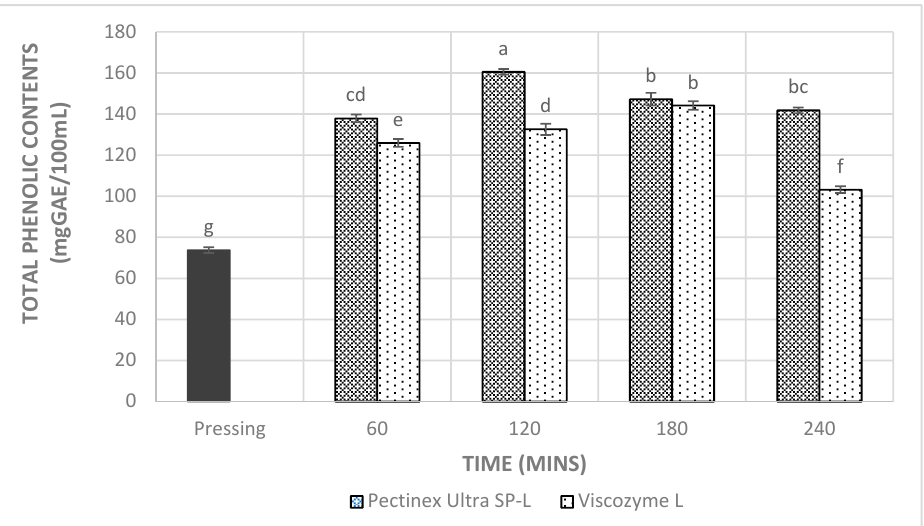
Figure 5. The effects of enzyme treatments on the total phenolic content of mulberry juice. The values are mean ± SD ( n = 3). Means sharing different letters are significantly different ( p < 0.05). Beverages 2018 , 4 , x FOR PEER REVIEW